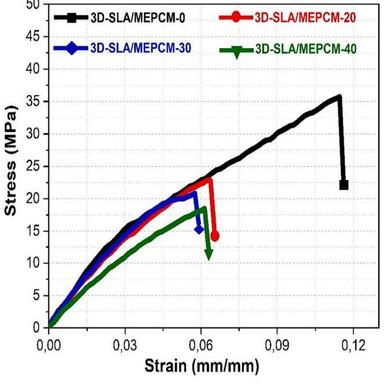
Tensile stress curves of the samples.